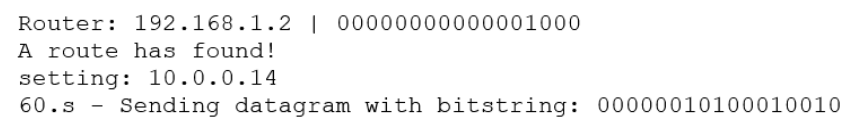
Figure 14. Inserting Bit-String (Source router).